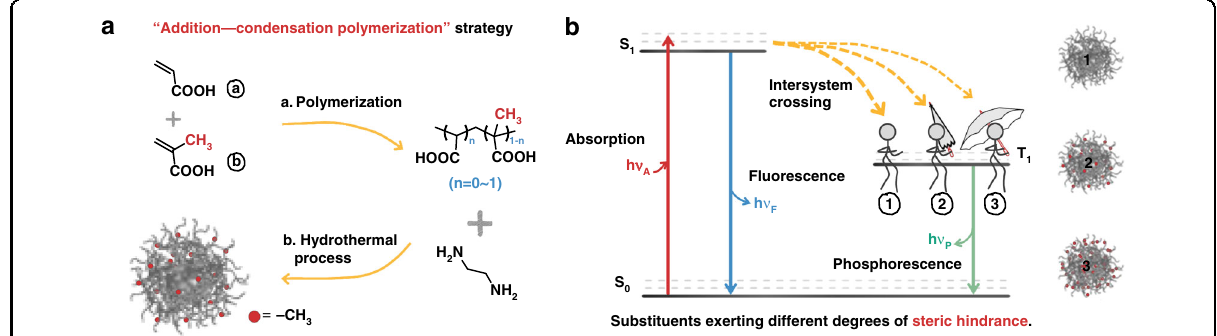
Fig. 1 General design for studying con fi ned-domain CEE in CPDs. a Schematic of the “ addition-condensation polymerization ” strategy. b Schematic Jablonski diagram of the possible PL mechanism for CPDs with substituents exerting different degrees of steric hindrance (1: no steric hindrance. 2: small steric hindrance. 3: large steric